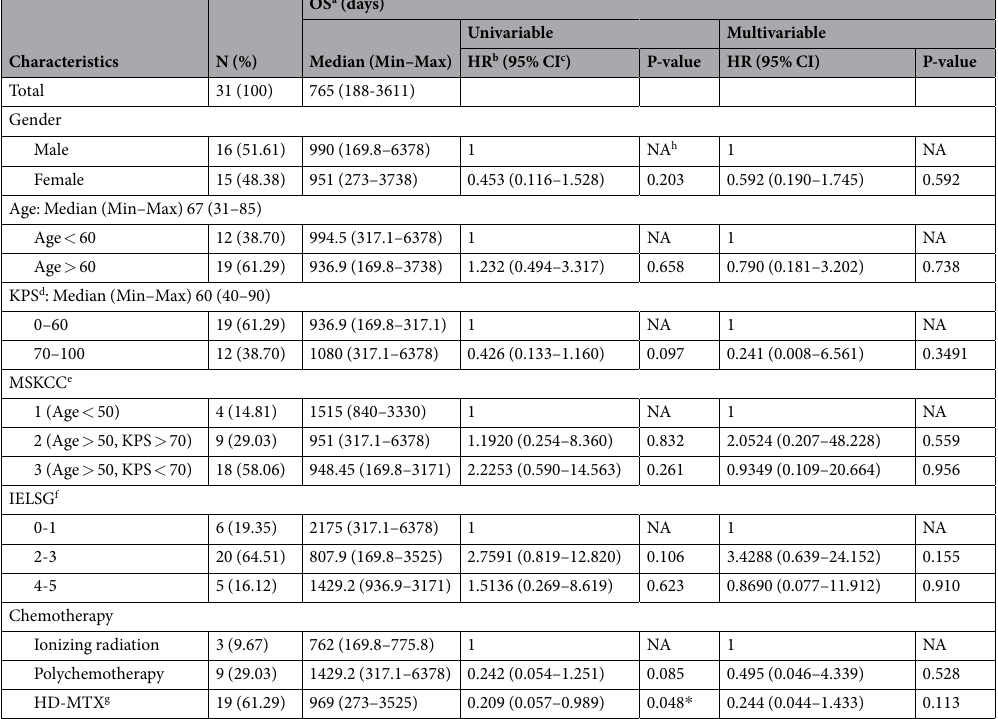
Table 1. Characteristics of the PCNSL patients examined in this study. Note: a OS; overall survival, b HR; hazard ratio, c CI; confidence interval, d KPS; Karnofsky Performance score, e MSKCC; Memorial Sloan Kettering Cancer Center risk score, f IELSG; International Extranodal Lymphoma Study Group risk score, g HD-MTX; high-dose methotrexate; h NA; not applicable, * P < 0.05, statistically